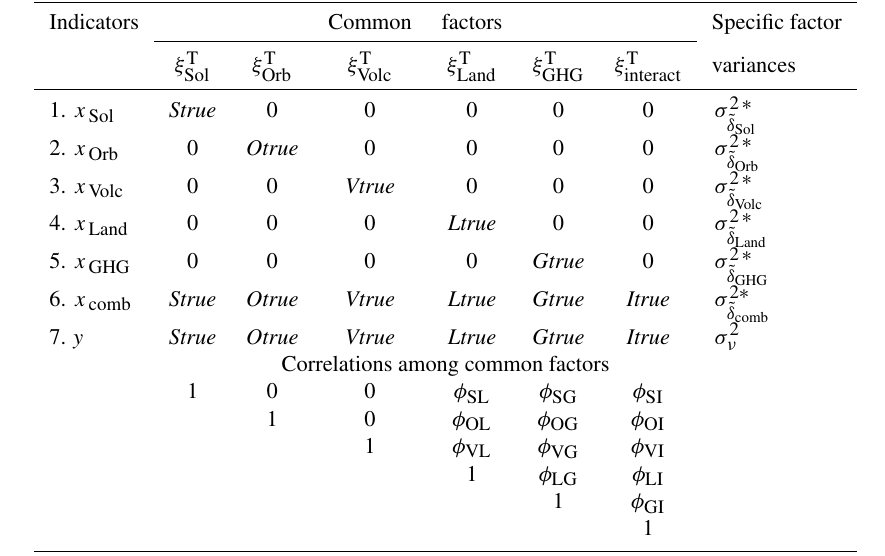
Table 1. Parameters of the seven-indicator and six-factor model, abbr. CFA(7, 6) model, hypothesising the consistency and the uncorrelat- edness between three latent